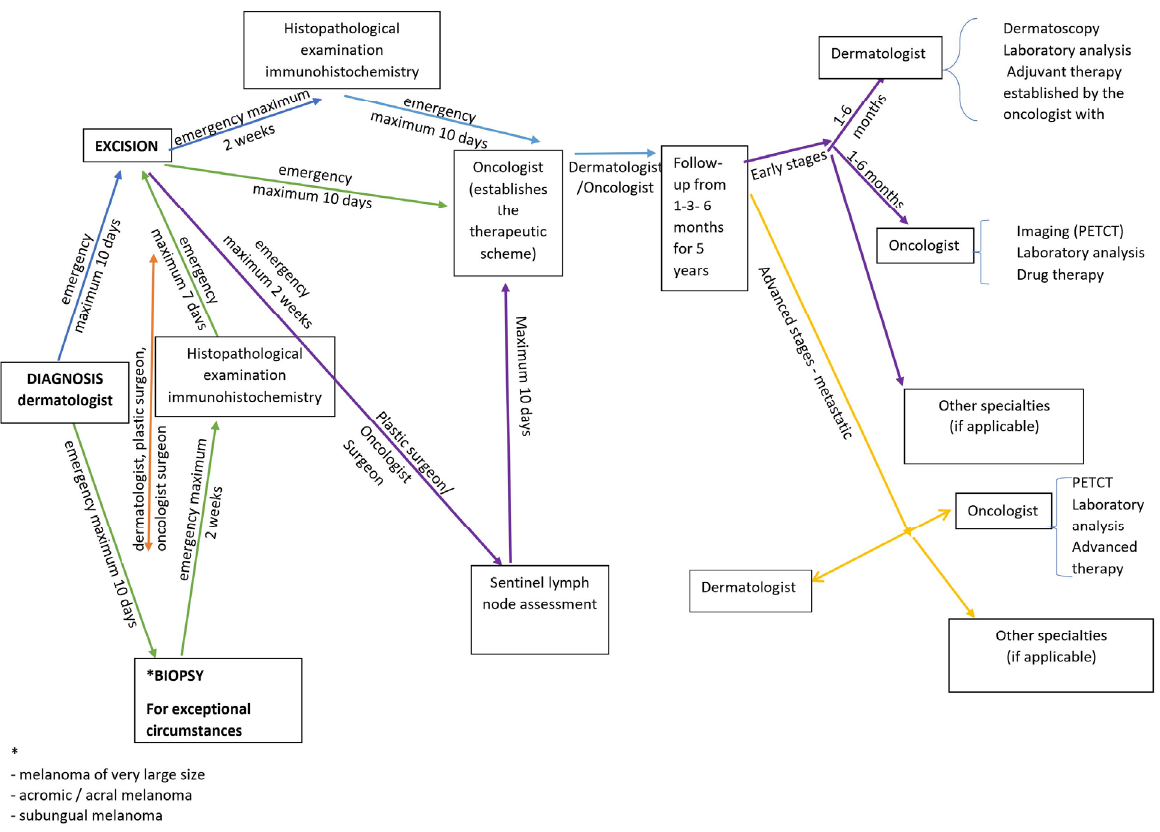
Figure 1. Romanian Society of Dermatology and Venereology algorithm for malignant melanoma.